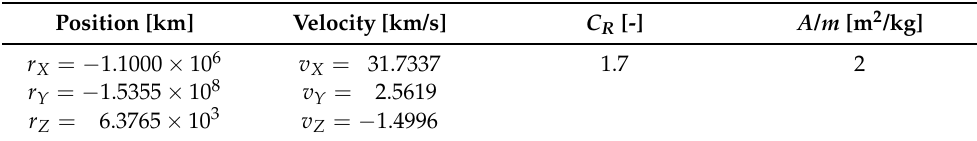
Table 3. Initial conditions for the propagation of the interceptor, taking 21 June 2017 at 00:00 TDB as the starting date [31] (Courtesy